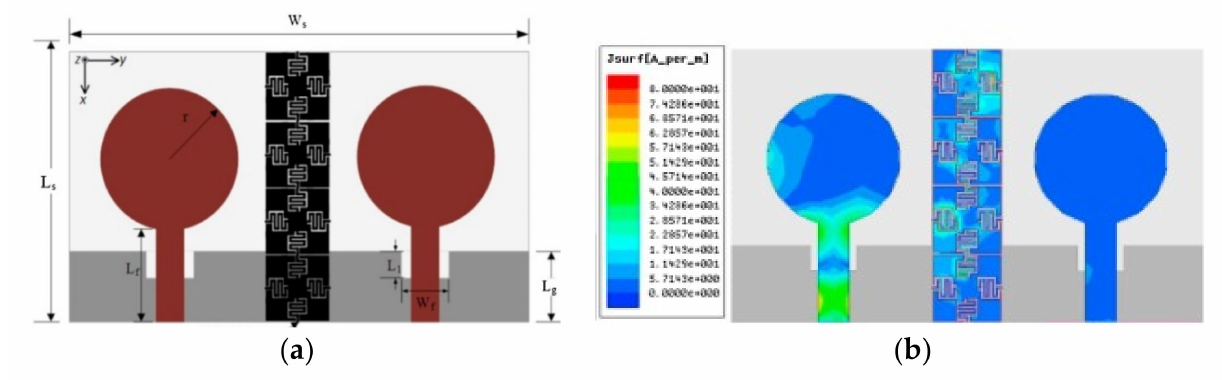
Figure 5. MIMO antenna with EBG: ( a ) geometry of proposed MIMO; and ( b ) current distributions (Results from